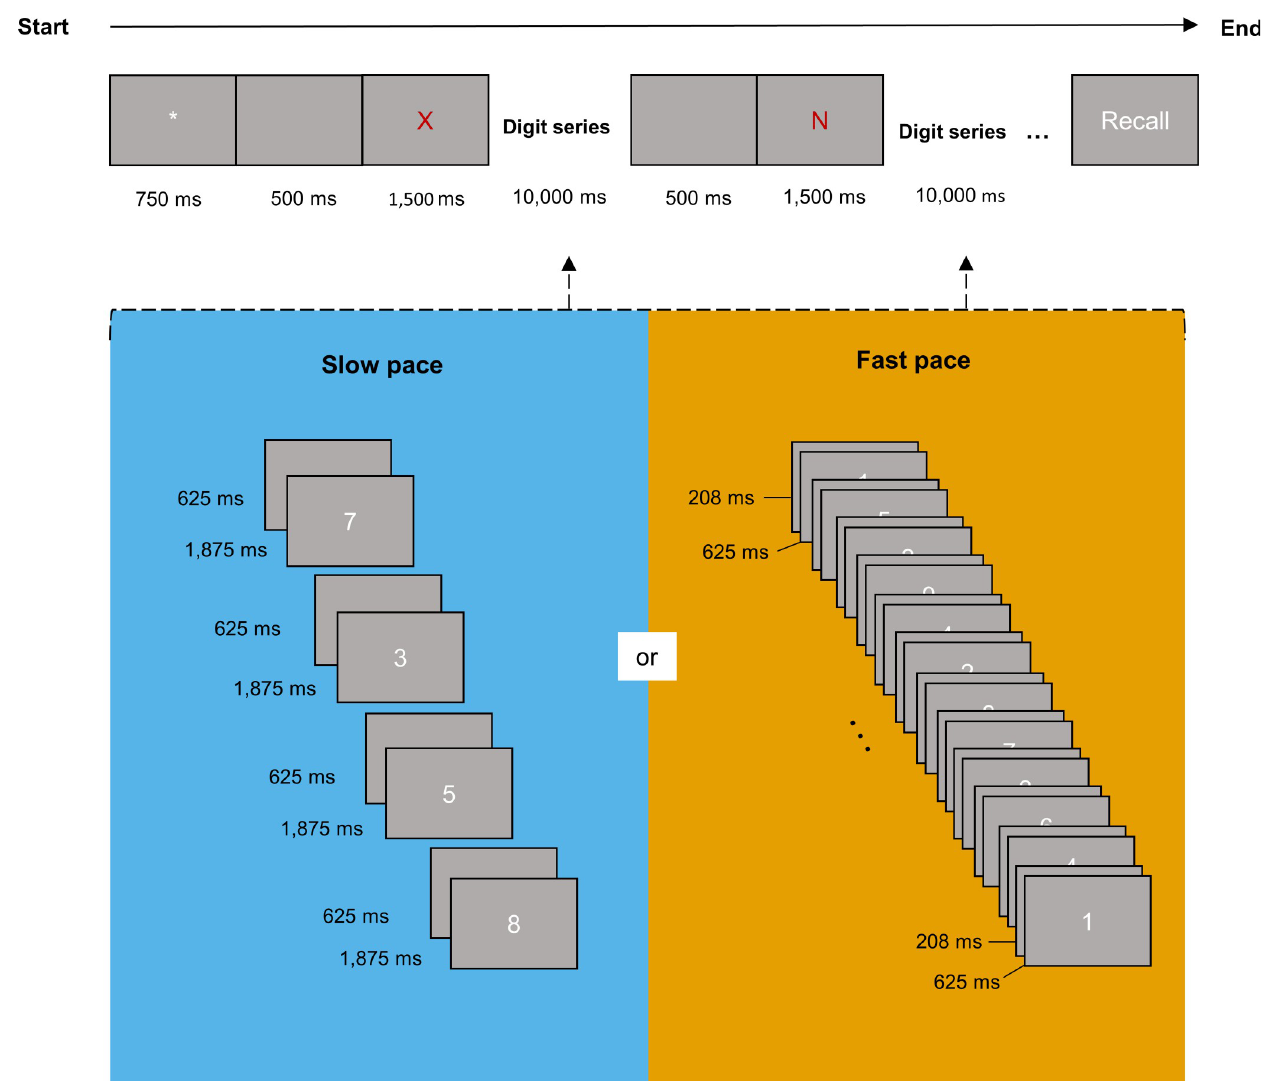
Fig 1. The reading-digit span task. In the task, participants were presented with lists of letters of increasing length and series of digits were interspaced between each letter in a list. To vary the cognitive load of the task, the interval between each letter was kept constant (10 s) but the number of digits presented in this interval varied (0.4 digit/second in the slow pace and 1.2 digit/s in the fast pace).